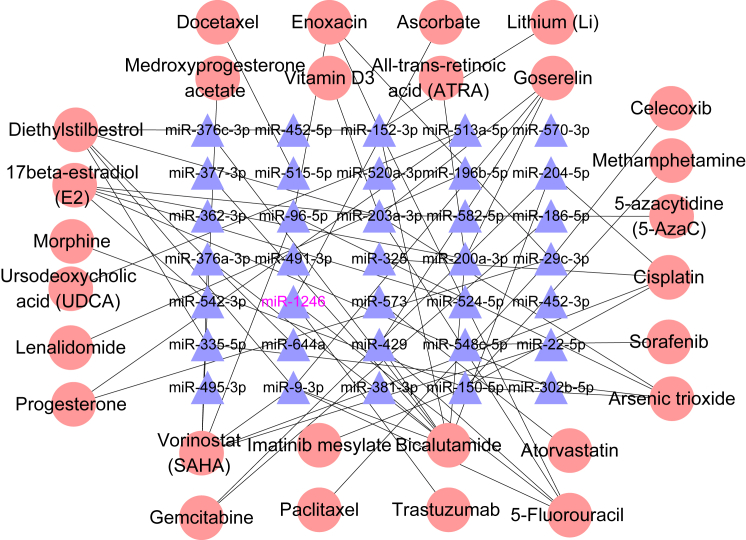
Drug Target AnalysisDrug-miRNA network was constructed by drugs approved by the US Food and Drug Administration in the SM2miR database and DEMs.